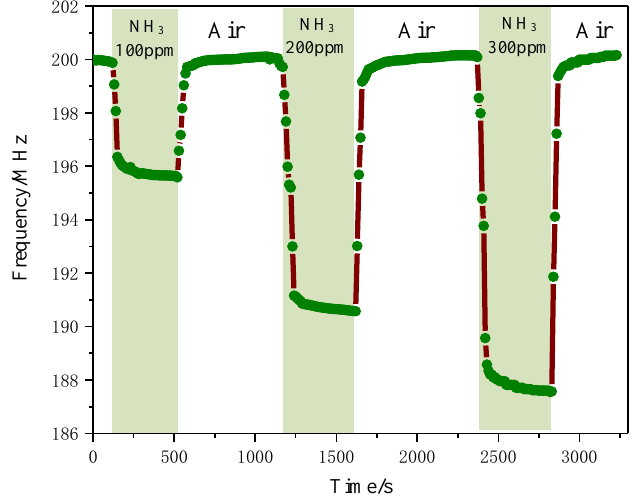
Figure 12. Response and recovery time curve at different concentrations: It can be seen that the variation of f 0 is 4.352 MHz, 9.235 MHz and 12.070 MHz, respectively; the sensitivity of gas sensor is about 0.04 MHz/ppm under the concentration of 300 ppm. With a low concentration, the variation of resonant frequency is relatively large.